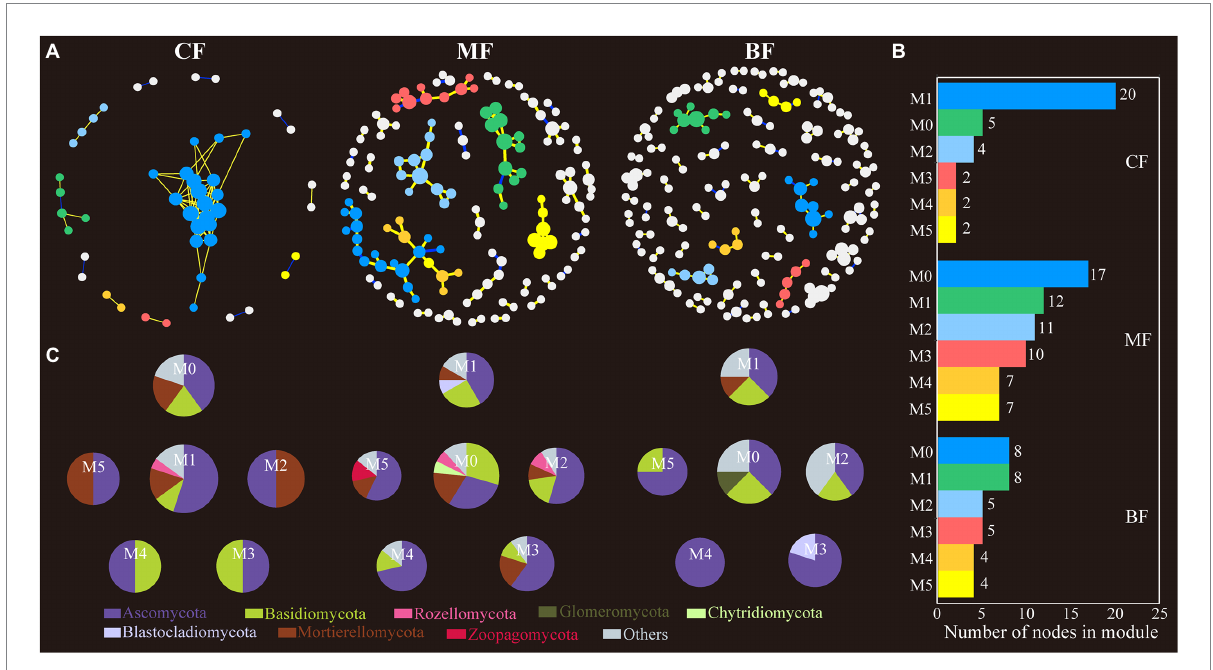
FIGURE 7 Fungal co-occurrence network (A) and the module analysis (B,C) based on correlation analysis under forest stand differences. The size of each node represents the degree. The yellow lines indicate positive interactions, blue lines indicate negative interactions, while the gray lines indicate correlations between each